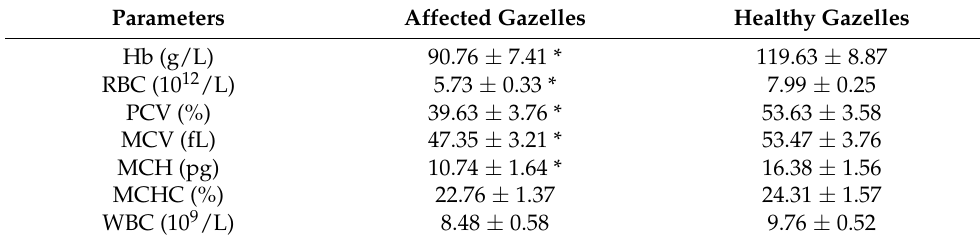
Table 3. Blood hematological levels in gazelles.